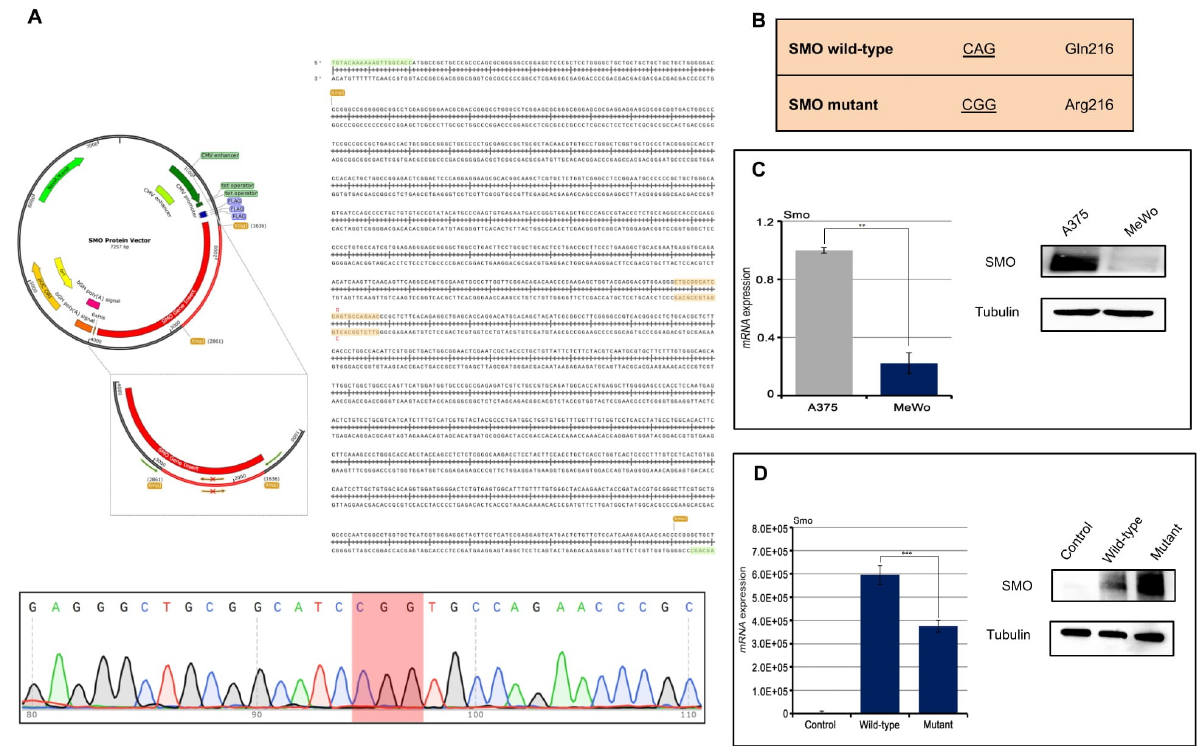
Figure 2. ( A , B ) MeWo cell lines were transfected with protein vector for SMO wild-type and SMO mutant (pPM-N-D-C-His) in order to introduce the mutation of interest (CAG vs. CGG); ( C ) Basal SMO expression in A375 cell lines, used as positive control, and MeWo cell lines evaluated by Western Blot assay and qRT-PCR analysis ( p < 0.01); ( D ) SMO expression was evaluated by Western Blot assay and qRT-PCR analysis ( p < 0.001) in MeWo cells parental and in the transfected ones. Control: MeWo parental cell line; Wild-type: MeWo cell line transfected with SMO wild-type vector; MeWo cell lines: transfected with SMO mutant vector. ** p < 0.01, *** p < 0.001.